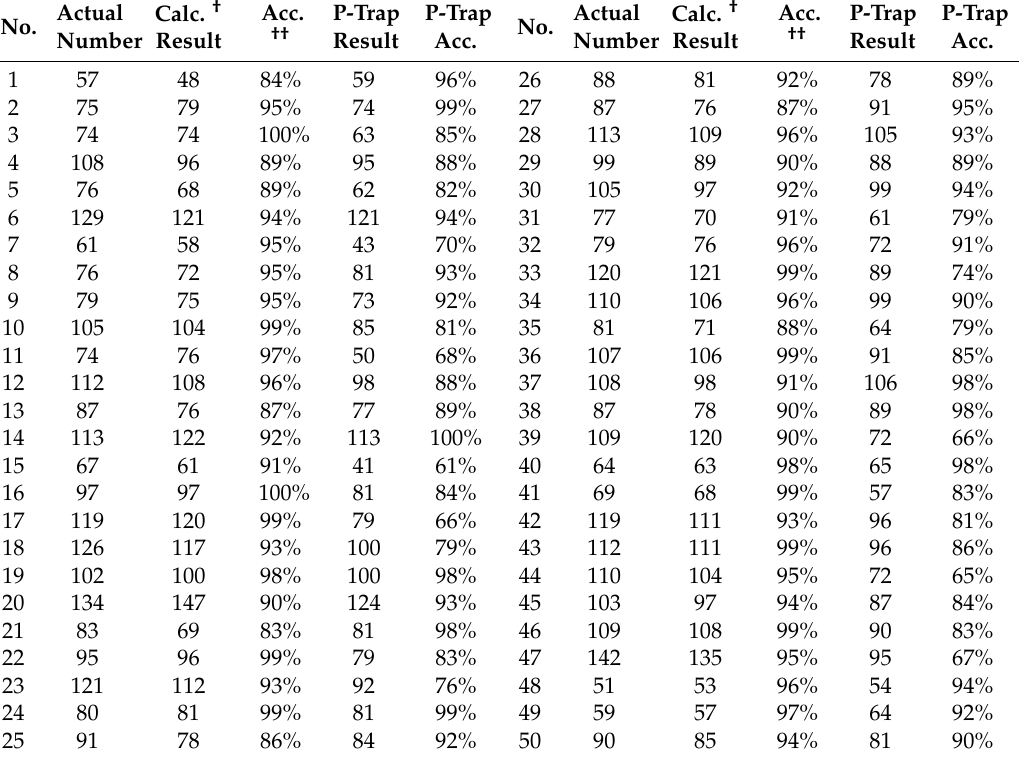
Table 3. Results for 50 panicle samples from a single O. sativa ssp. japonica cultivar